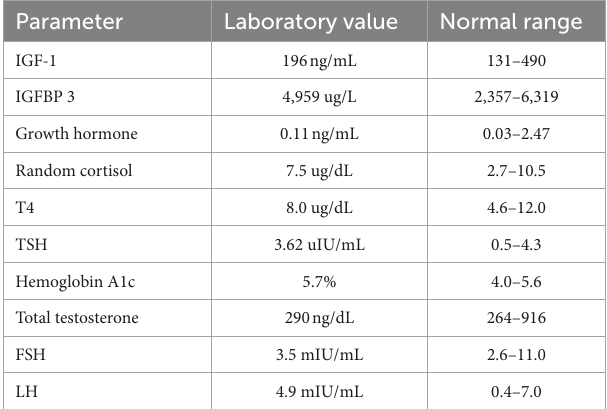
TABLE 1 Subject’s baseline biochemical